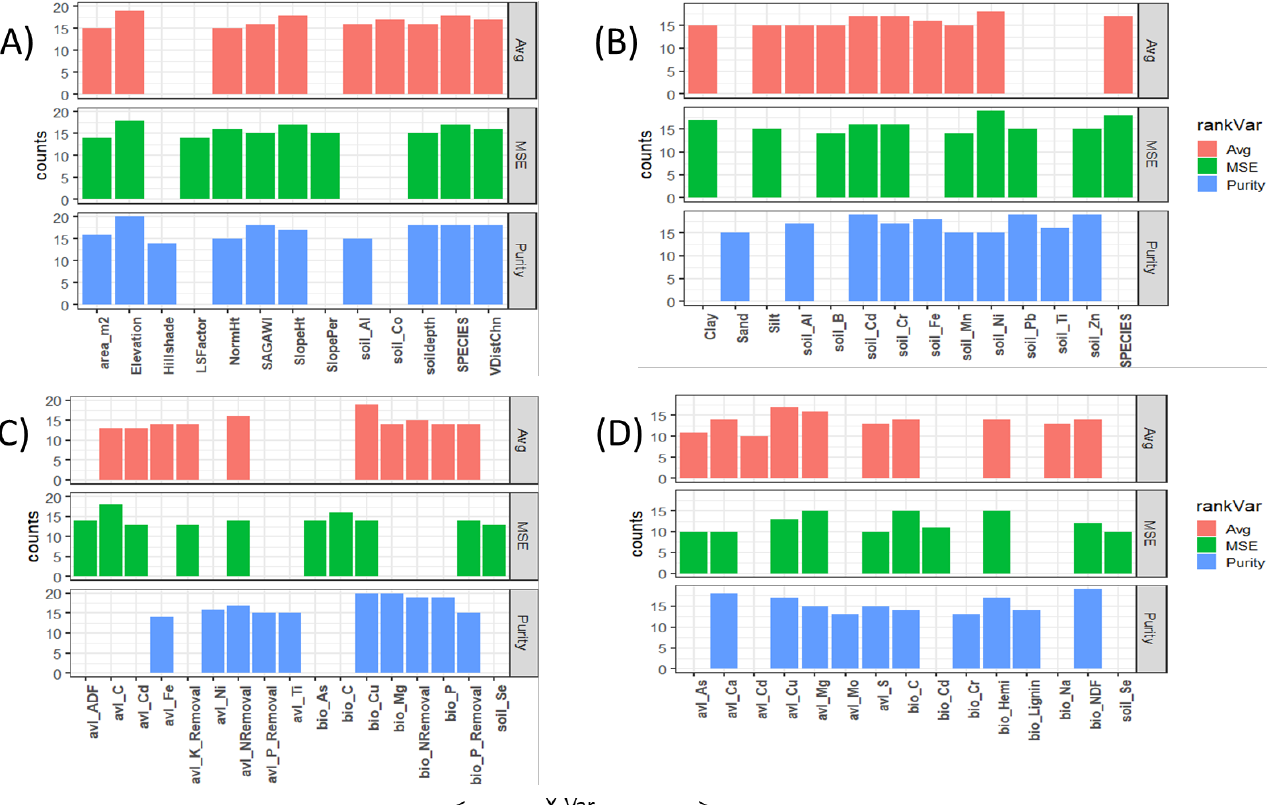
Figure 3. Important ten variables selected per cluster based on random forest model using MSE, node purity and average ranking of MSE, and node purity criteria; ( A ) variables selected for cluster 1, ( B ) variables selected for cluster 2, ( C ) variables selected for cluster 3, and ( D ) variables selected for cluster 4. See Table 1 for the variable description. 2.5. Animal Grazing Preference Modeling Using Variables Selected by RF-Based Variable Ranking Method Selected variables based on the averaged ranking method were used to predict ani- mal grazing preference. Summer active grazing hour per ha per AU (labeled as “grz_hr_ha”) was averaged for all 3 years (2017, 2018 , and 2019) for this study. The ran- dom forest variable selection method described previously resulted in 10 variables per cluster that were important for system-level analysis. These 40 variables (10 per cluster) were selected to model grazing preference using two approaches: MLR method and the CART method. Outputs from these two methods were compared for the grazing prefer- ence interpretation. For MLR, a stepwise regression using both backward and forward